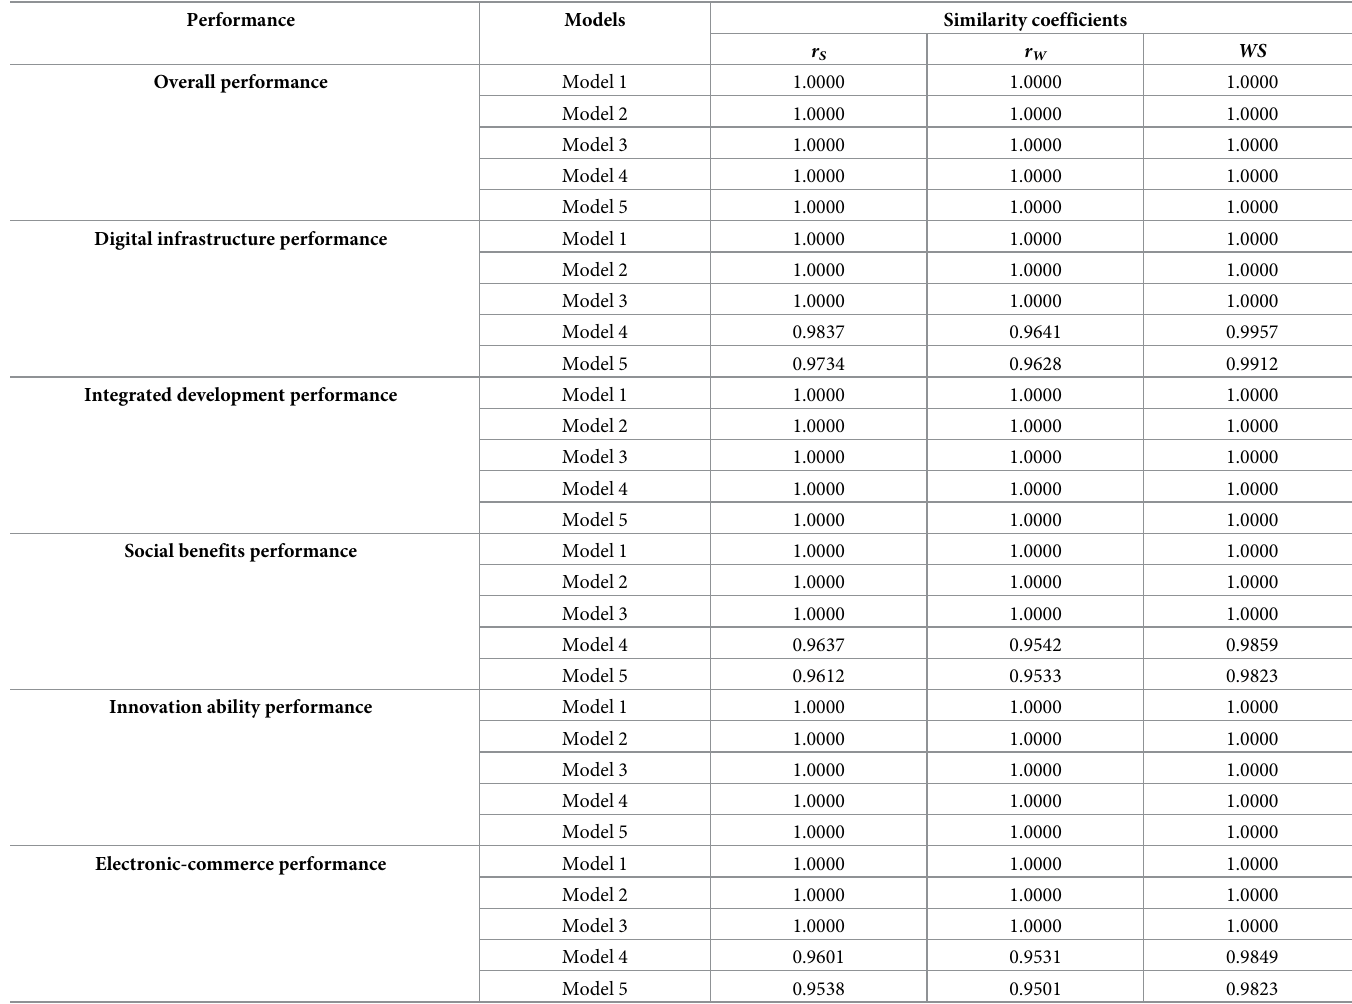
Table 10. Similarity coefficients between the rankings of the established model and 4 comparison